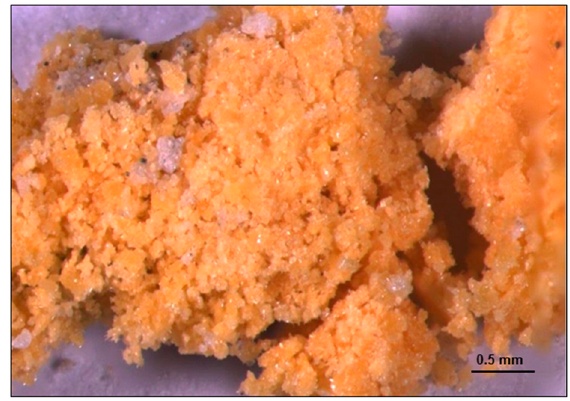
Figure 9. Stereomicroscope image of deep-yellow copiapite.